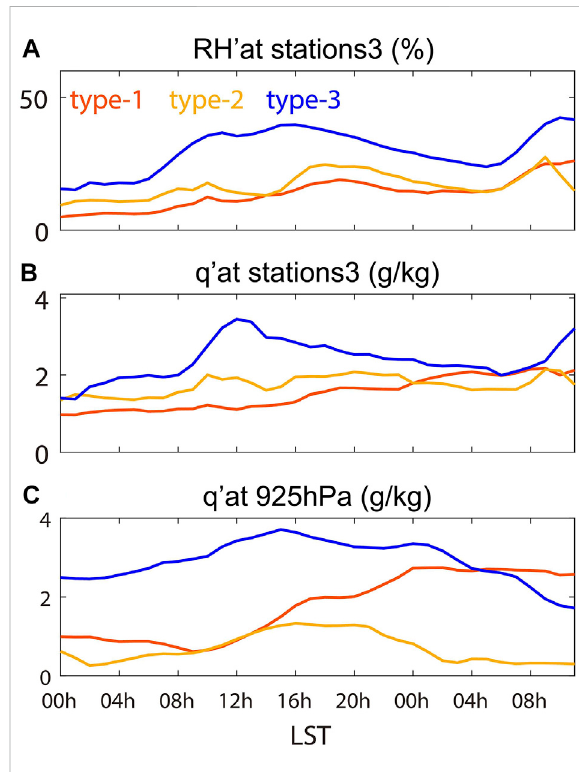
FIGURE 10 Composite results of anomalous RH (a; %), anomalous q (b; g/kg), and anomalous q at 925 hPa (c; g/kg). Red, yellow, and blue curves represent type-1, type-2, and type-3 SFP events, respectively. (A) and (B) are based on station S3. (C) is based on the regional average of the Qingdao area (120.05 ° -120.5 ° W,